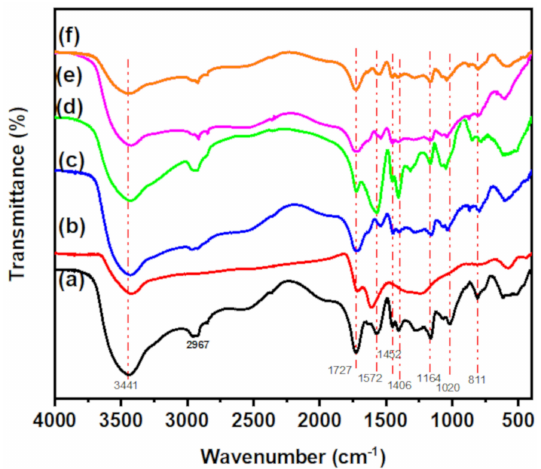
Figure 2. FTIR of ( a ) CT- g -PAA, ( b ) O-ECNFs, ( c ) CT- g -PAA / O-ECNFs-0.5 ( d ) CT- g -PAA / O-ECNFs-1.0 ( e ) CT- g -PAA / O-ECNFs-1.5 and ( f ) CT- g -PAA /